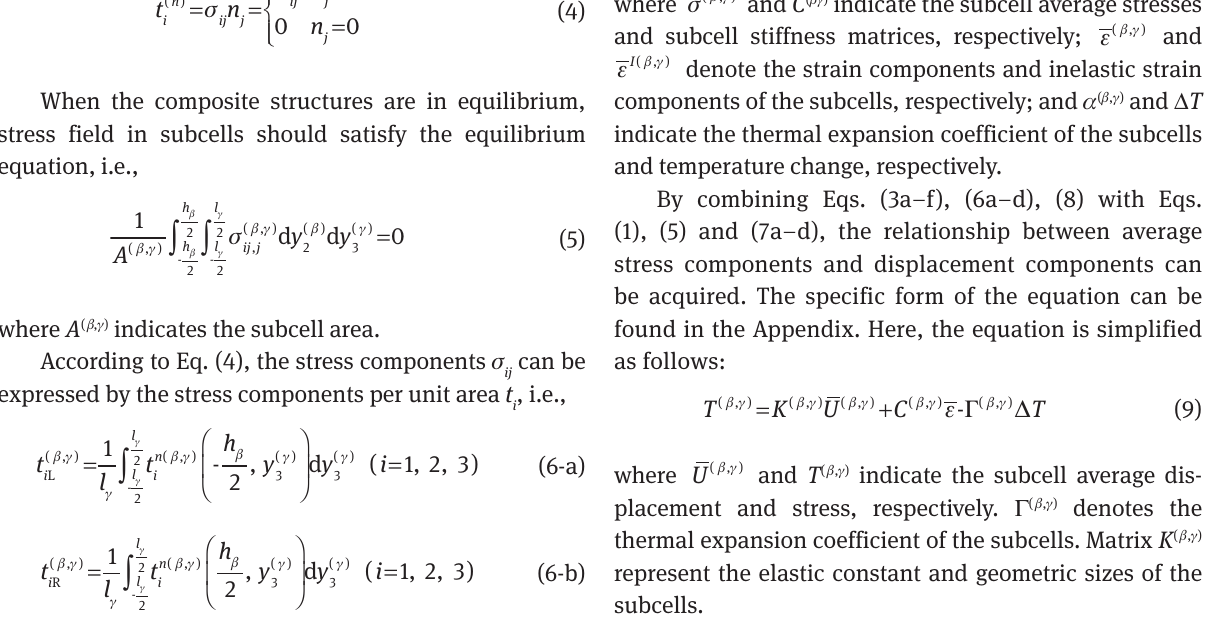
where ( , ) U β γ and T ( β , γ ) indicate the subcell average dis- placement and stress, respectively. Γ ( β , γ ) denotes the thermal expansion coefficient of the subcells. Matrix K ( β , γ ) represent the elastic constant and geometric sizes of the